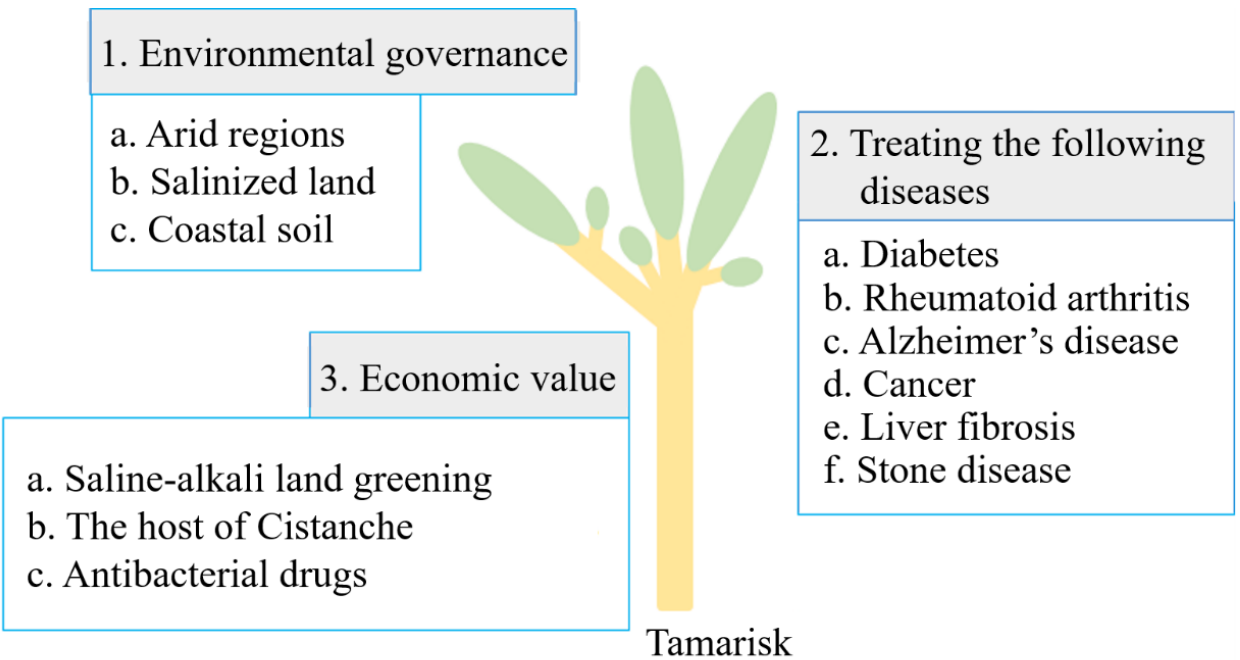
Figure 2. Main application value of tamarisk in three aspects.